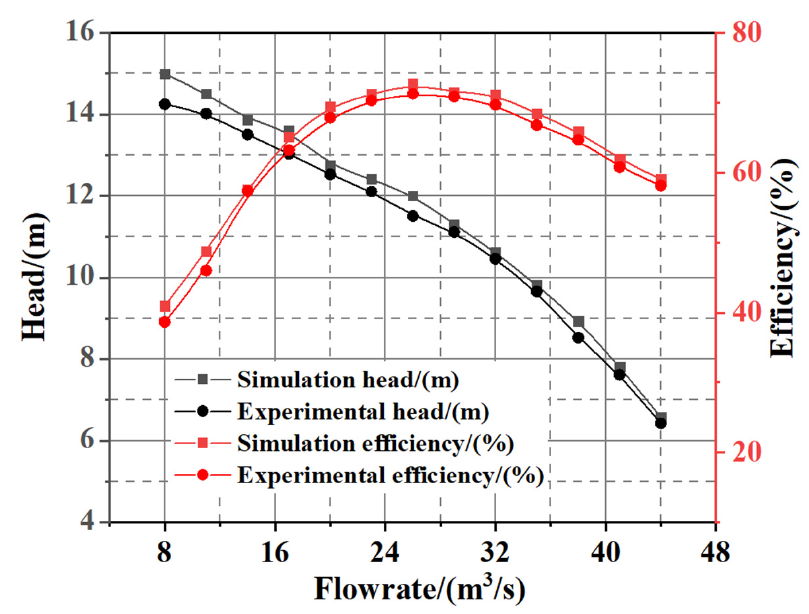
Figure 18. Comparison of external characteristics under the clean water condition.